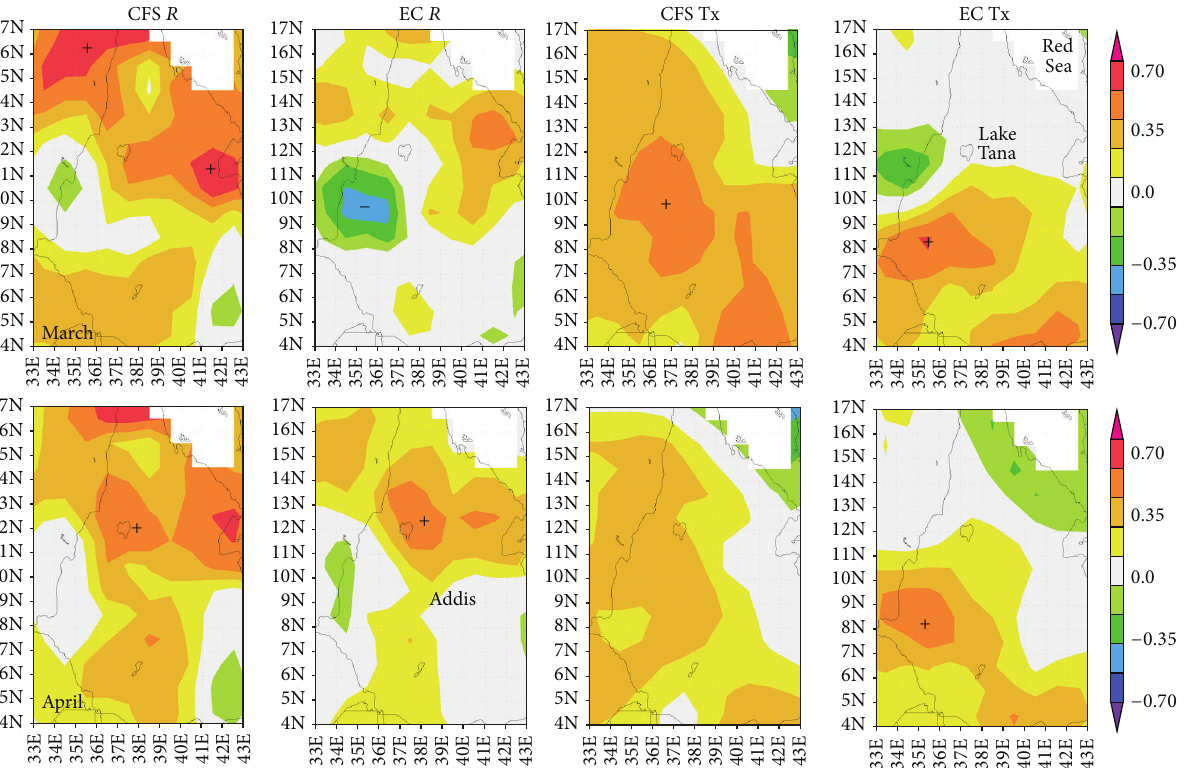
Figure 3: Spatial maps of correlation between CFS and ECMWF model outputs (columns) 1981–2006 and GPCC rain/CRU3 temp observations at two lead times (rows) labelled by forecast month, for JJA rainfall (left) and maximum temperature (right). A few place names are given for reference. The first shaded level is